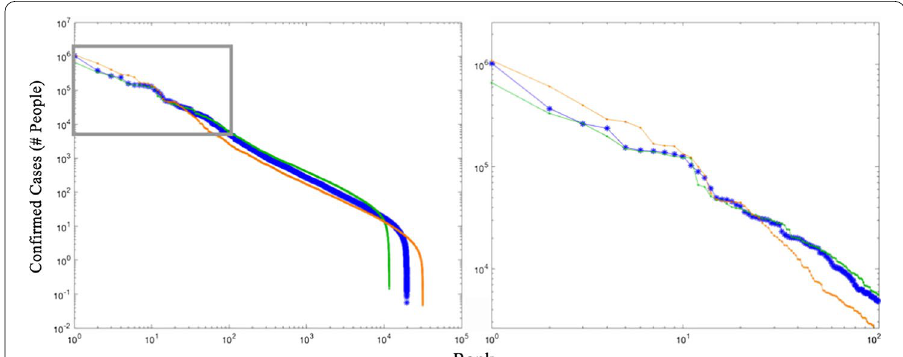
Fig. 8 USA COVID-19 confirmed case network scales similarly regardless of low luminance threshold. High threshold (thin green) results in fewer, larger components than low threshold (thin orange). Intermediate threshold (thick blue) shows the emergence of the largest component (Northeast Corridor) but similar scaling to high threshold for other components in the upper tail. All thresholds show rank-size linearity suggesting scale-free behavior spanning 4 orders of magnitude. Upper tail (gray box; enlarged at right) + shows percolation-like behavior at low threshold, with the ~ 30 largest components disproportionately larger than the remainder of the distribution